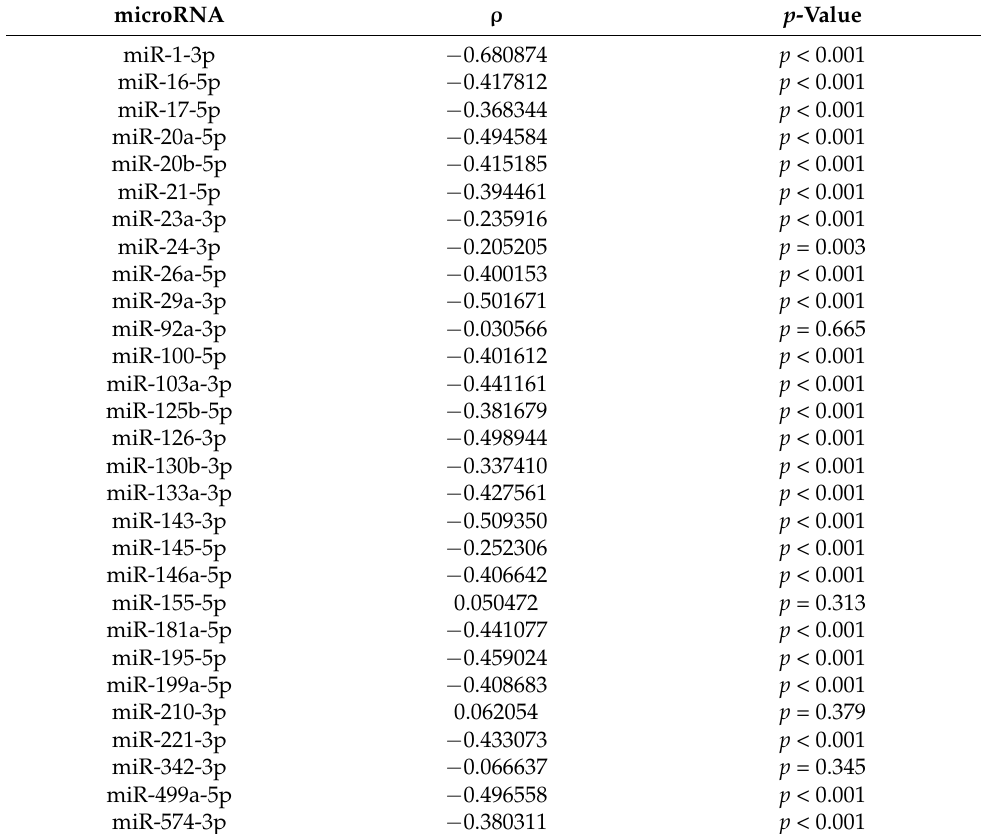
Table 3. Postnatal increase in microRNA gene expression with descending gestational age at delivery. microRNA ρ p